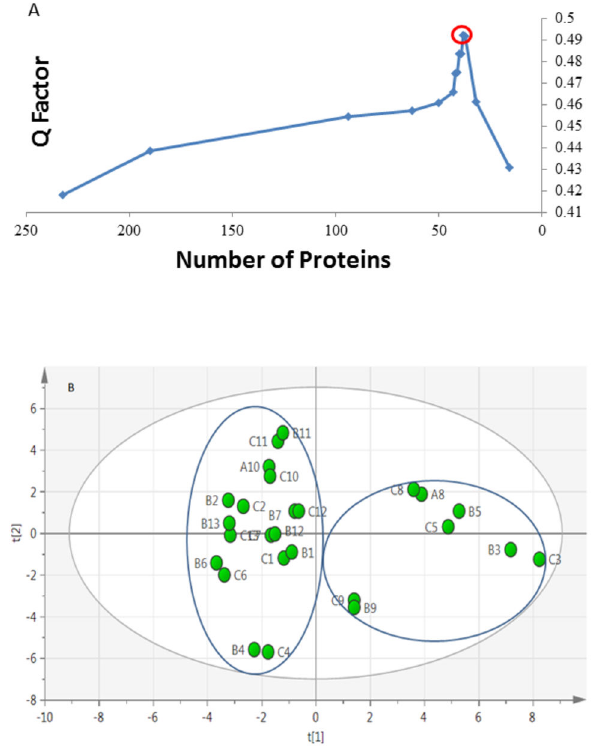
Figure 1. Quality factor Q against number of proteins N included in the model. The proteins were sorted according to the number of detected peptides per protein, and N top proteins were retained for the model. The highest Q corresponds to a model N=38 proteins, which was accepted as the best model (A). Unsupervised PCA scores plot based on 38 quantified proteins across all 13 samples. All the replicates were close to each other and there was no statistical outlier (B). doi: